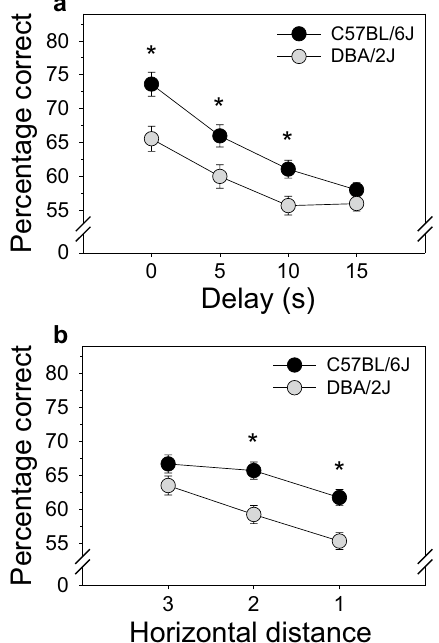
Figure 3. Mouse strain significantly influenced the effect of delay and horizontal distance, but not vertical distance, on TUNL performance in C57BL/6J and DBA/2J mice ( a ) Percentage correct on the 0, 5, and 10 s delay was significantly higher in C57BL/6J mice than in DBA/2J mice. Performance of C57BL/6J mice and DBA/2J mice did not differ significantly on the 15 s delay. The largest difference between C57BL/6J and DBA/2J mice was observed on the 0 s delay during which working memory would be expected to have a negligible impact on performance. (b) Performance of C57BL/6J mice and DBA/2J mice did not differ on the easiest discrimination during which the two choice-phase stimuli were displayed at the widest distance. In contrast, performance of DBA/2J mice was significantly impaired relative to C57BL/6J mice on more difficult discriminations during which stimuli were displayed at narrower distances. The two-way interactions illustrated here are fully decomposed in Fig. 4. Error bars represent SEM. * p <